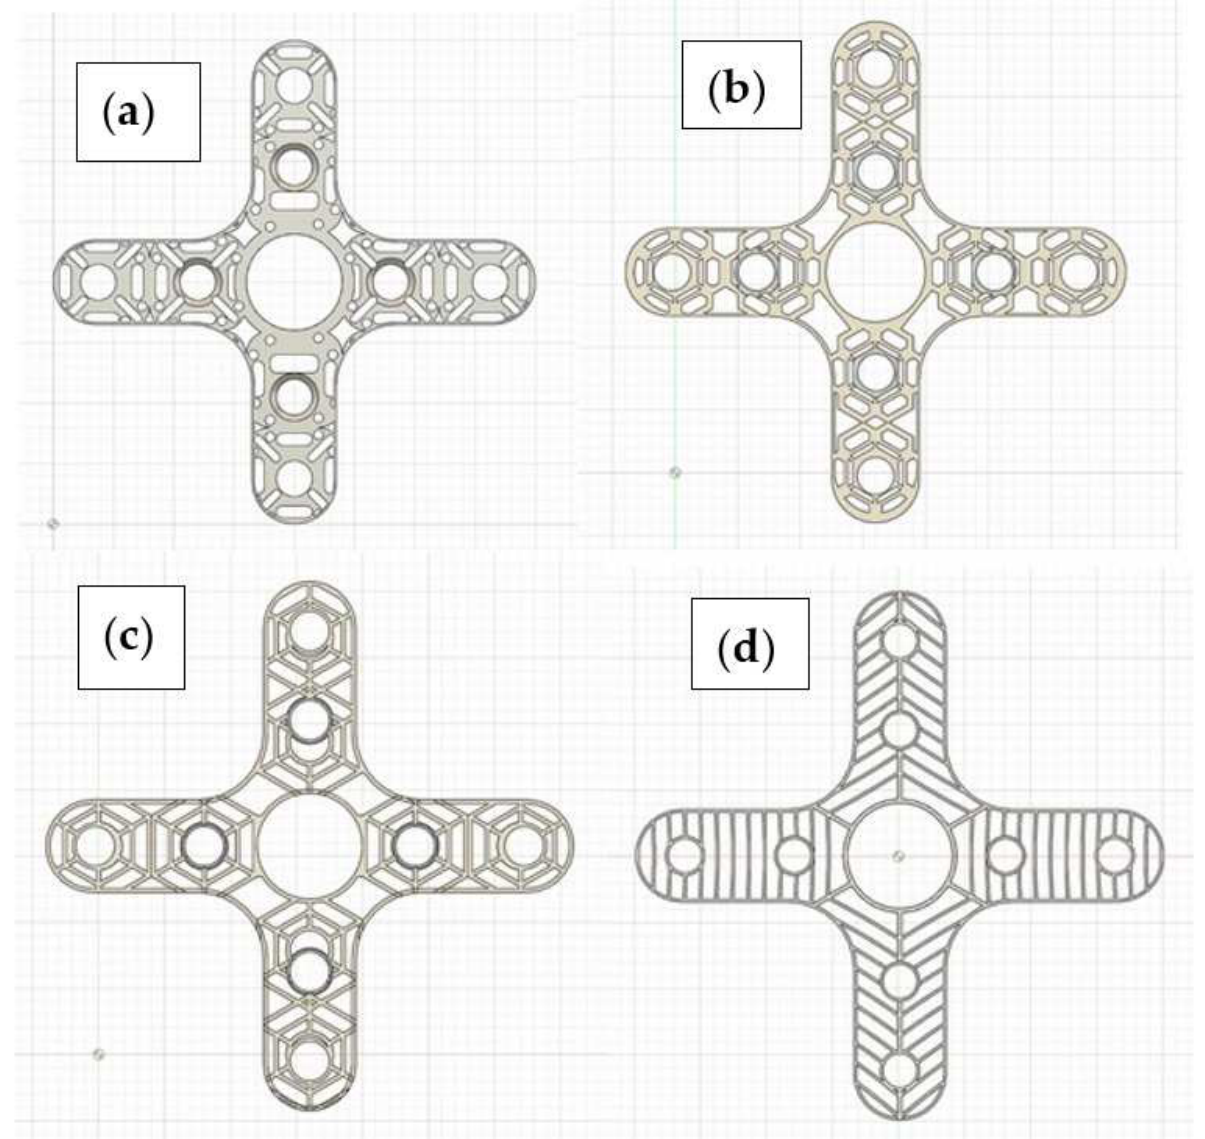
Figure 8. Final lattice structure to be used as a motor holder, ( a ) polyhedral, ( b ) snowflake, ( c ) circular spider web, ( d ) linear spider web.